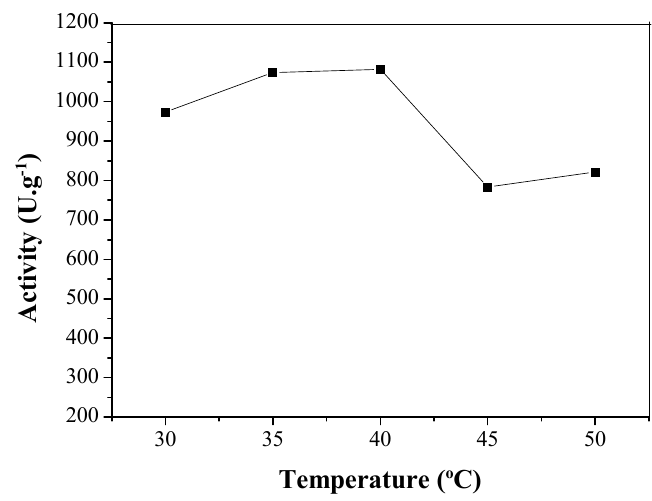
Figure 8. Temperature optimum of CTA-LU with lipase activity measured at pH 7.